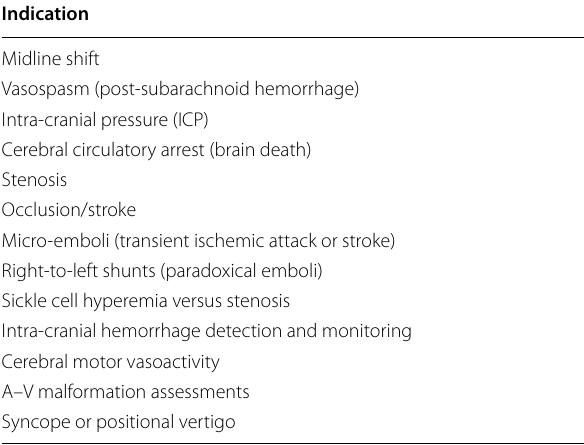
Table 1 Indications for transcranial ultrasonography and